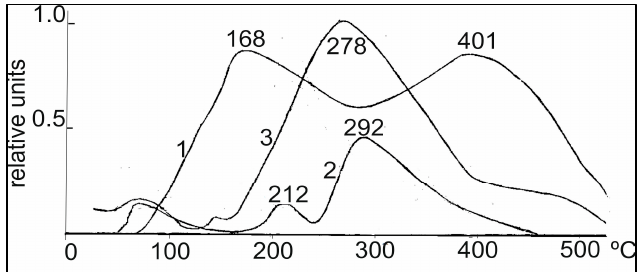
Figure 3. Thermal desorption of hydrogen from various catalysts in the mode of linear temperature increase from 0 to 750 ◦ C: 1. 0.5% Rh / γ -Al 2 O 3 ; 2. 0.5% Rh-Pt(5:5) / γ -Al 2 O 3 ; 3. 0.5% Rh-Pt(9:1) / γ -Al 2 O 3